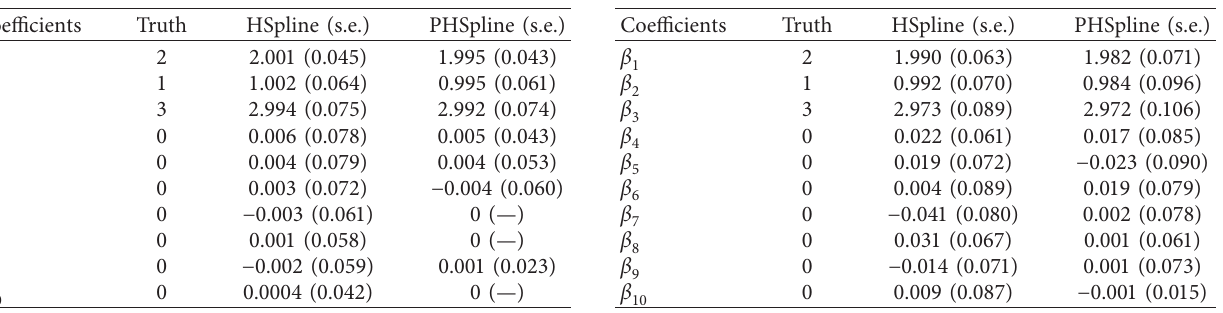
Table 5: Simulation result of Example 3.